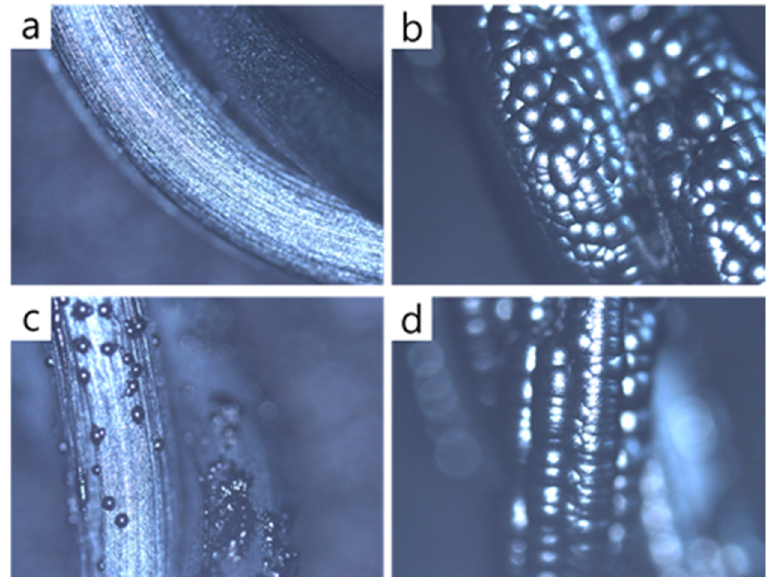
Figure 4. Optical microscope images of the filament surface ( a ) without the graphite coating at a filament temperature of 2100 °C at 1% CH 4 –99% H 2 and ( b ) fully coated with the graphite at a filament temperature of 2100 °C at 3% CH 4 –97% H 2 , ( c ) partially coated with carbon precipitates at a filament temperature of 1900 °C at 1% CH 4 –99% H 2 , and ( d ) fully coated with the graphite at a filament temperature of 1900 °C at 3% CH 4 –97% H 2 .